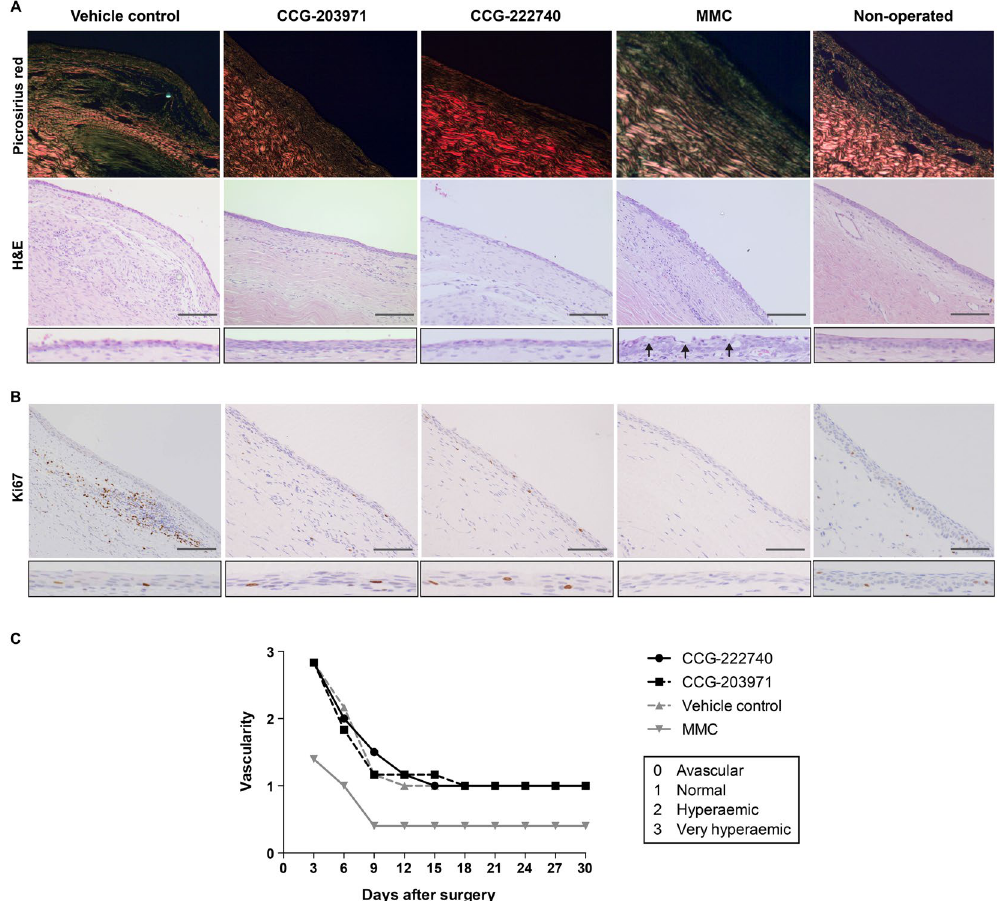
Figure 6. CCG-222740 and CCG-203971 preserve the conjunctival epithelium and do not cause any local toxicity. Sections were cut and stained as in Fig. 5. ( A ) H&E and Picrosirius red staining. Arrows indicate disruption of epithelium with MMC treatment. Scale bar = 100 μ m. ( B ) Ki67 staining for proliferation. ( C ) Conjunctival vascularity as an indicator of local